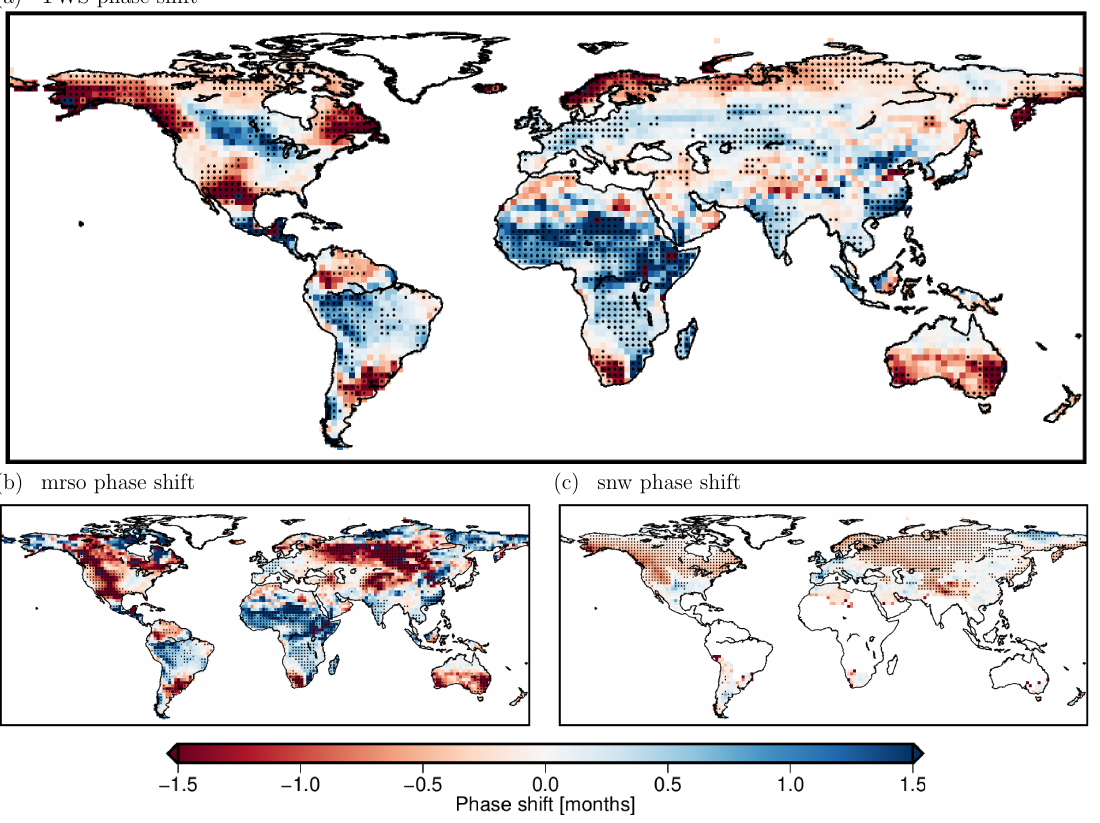
Figure 8. ( a ) MMMed mTWS phase shift of the annual cycle over 2000–2100. Stippling indicates regions where 13 or more of 17 models (i.e., ≥ 76%) agree on the sign of the amplitude change. ( b , c ) same as ( a ) but for mrso and